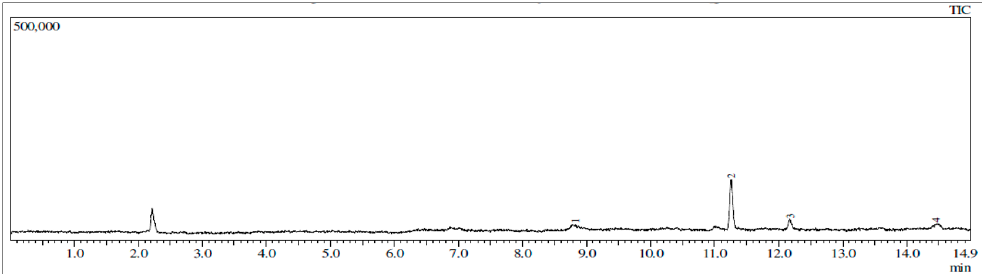
Figure 8. The GC chromatogram of Ageratum active fraction showing four peaks in a different retention time. The peak at 2.250 min is of chloroform which is used as solvent.